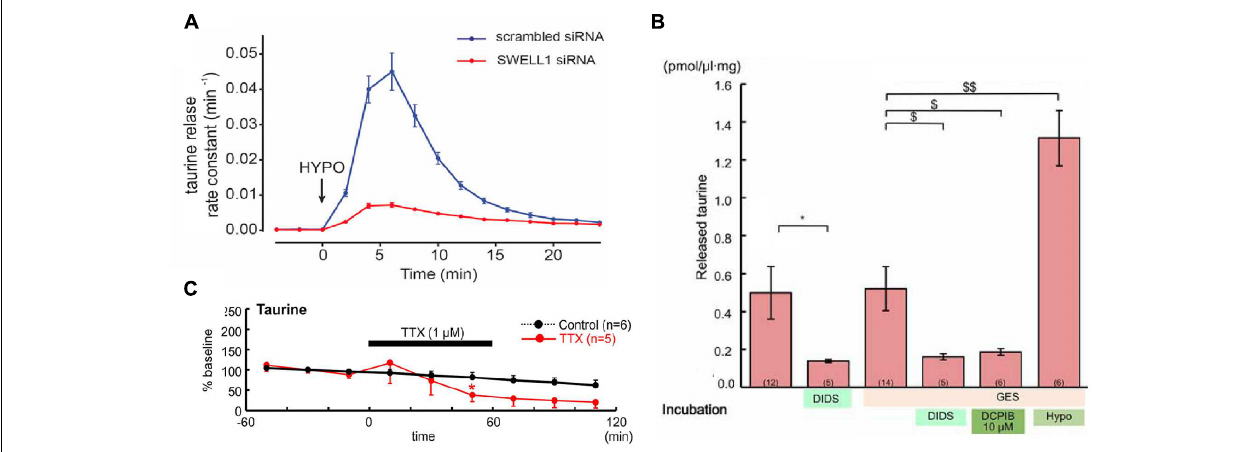
FIGURE 1 | Taurine release pathways. (A) The taurine release from HeLa cells after hypoosmotic stimulation was massively attenuated if expression of the volume-regulated anion channel SWELL1 was suppressed (with permission from Qiu et al., 2014). (B) The taurine release from embryonic neocortical slices loaded with 10 mM taurine was not affected by the TauT inhibitor GES, could be blocked the unspecific anion channel blocker DIDS or by DCPIB, a selective blocker of volume-regulated anion channels, and was stimulated by hypoosmotic stimulation (hypo), suggesting that taurine efflux was mainly mediated by volume-regulated anion channels ( ∗ and $ represent P < 0.05, $$ indicate P < 0.01, with permission from Furukawa et al., 2014). (C) Suppression of electrical activity attenuated the spontaneous taurine release from tangential slices of early postnatal rat neocortex, suggesting the existence of a constitutive, activity-dependent taurine release (modified with permission from Qian et al.,